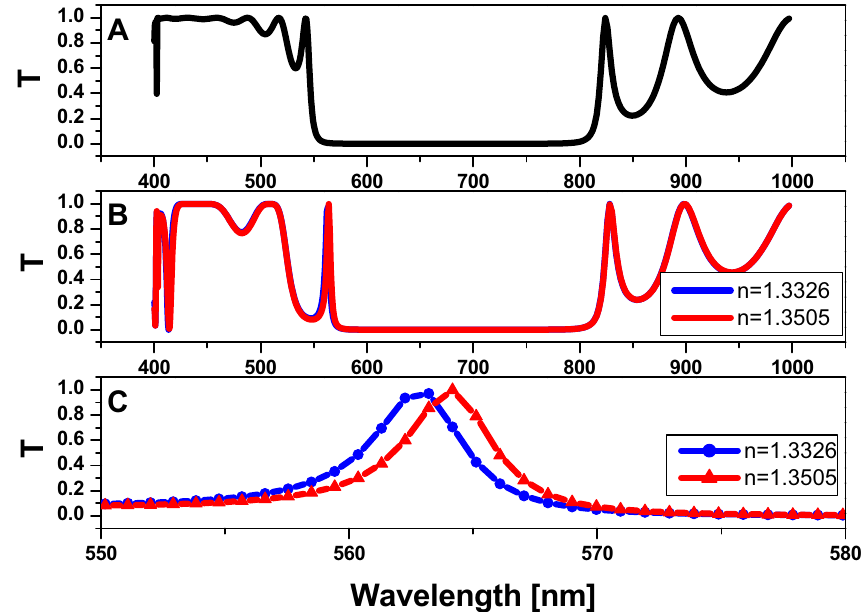
Figure 7. The transmission property of the two-dimensional hexagonal cylinder unit cell with R = 80nm D = 80nm , N = 5, and the host material is titanium dioxide ( TiO 2 ) . ( A ) All cylinders are filled with air , ( B ) All cylinders are filled with air except the centered pour which filled with saline water with different values of refractive index, and ( C ) zoom on defect peak on figure B.